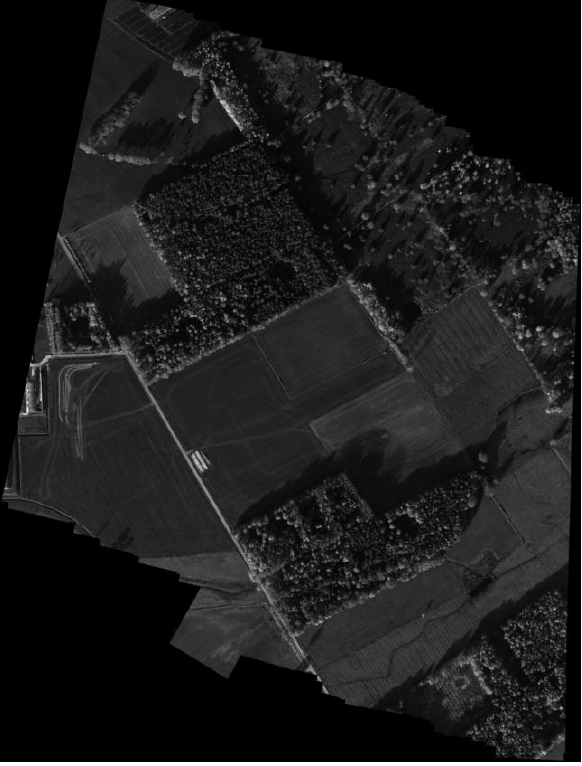
Figure 11 panchromatic composite at 10 cm GSD derived from the panchromatic sensor